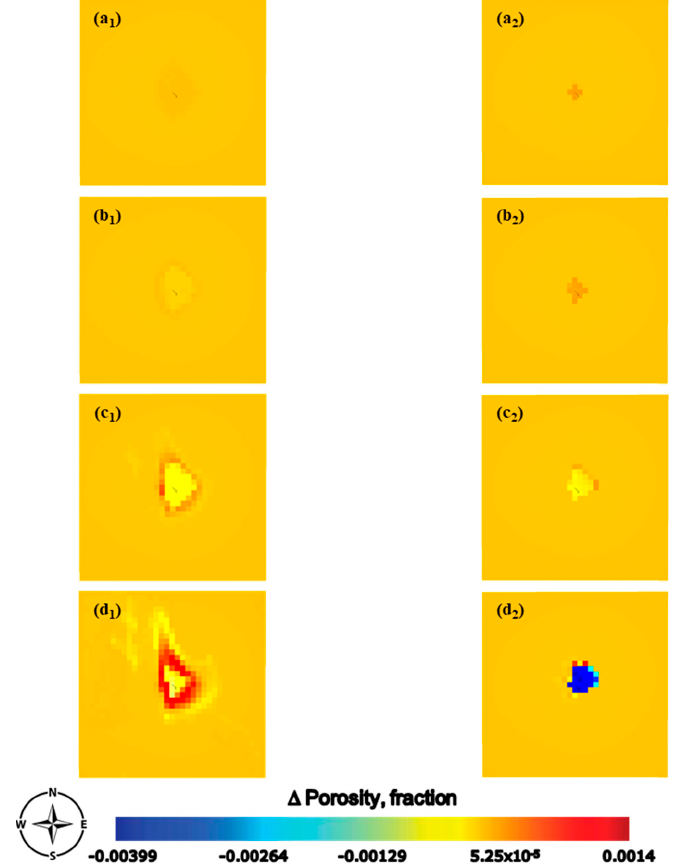
Figure A7. Plan view diagrams illustrating the simulated ∆ porosity evolution for the base case from the arkosic layer top view ( a 1 , b 1 , c 1 , d 1 ) and homogenous case from the Upper Mt. Simon top view ( a 2 , b 2 , c 2 , d 2 ) at ( a ) 30 years, ( b ) 100 years, ( c ) 1000 years, and ( d ) 10,000 years. Each figure’s size is 35 km × 35 km (x, y).